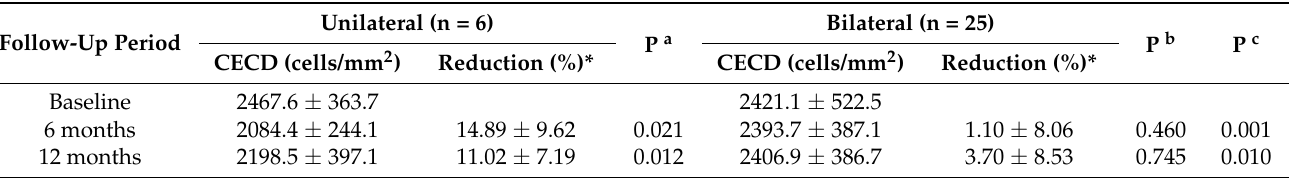
Table 4. Comparison of CECD in patients with unilateral and bilateral